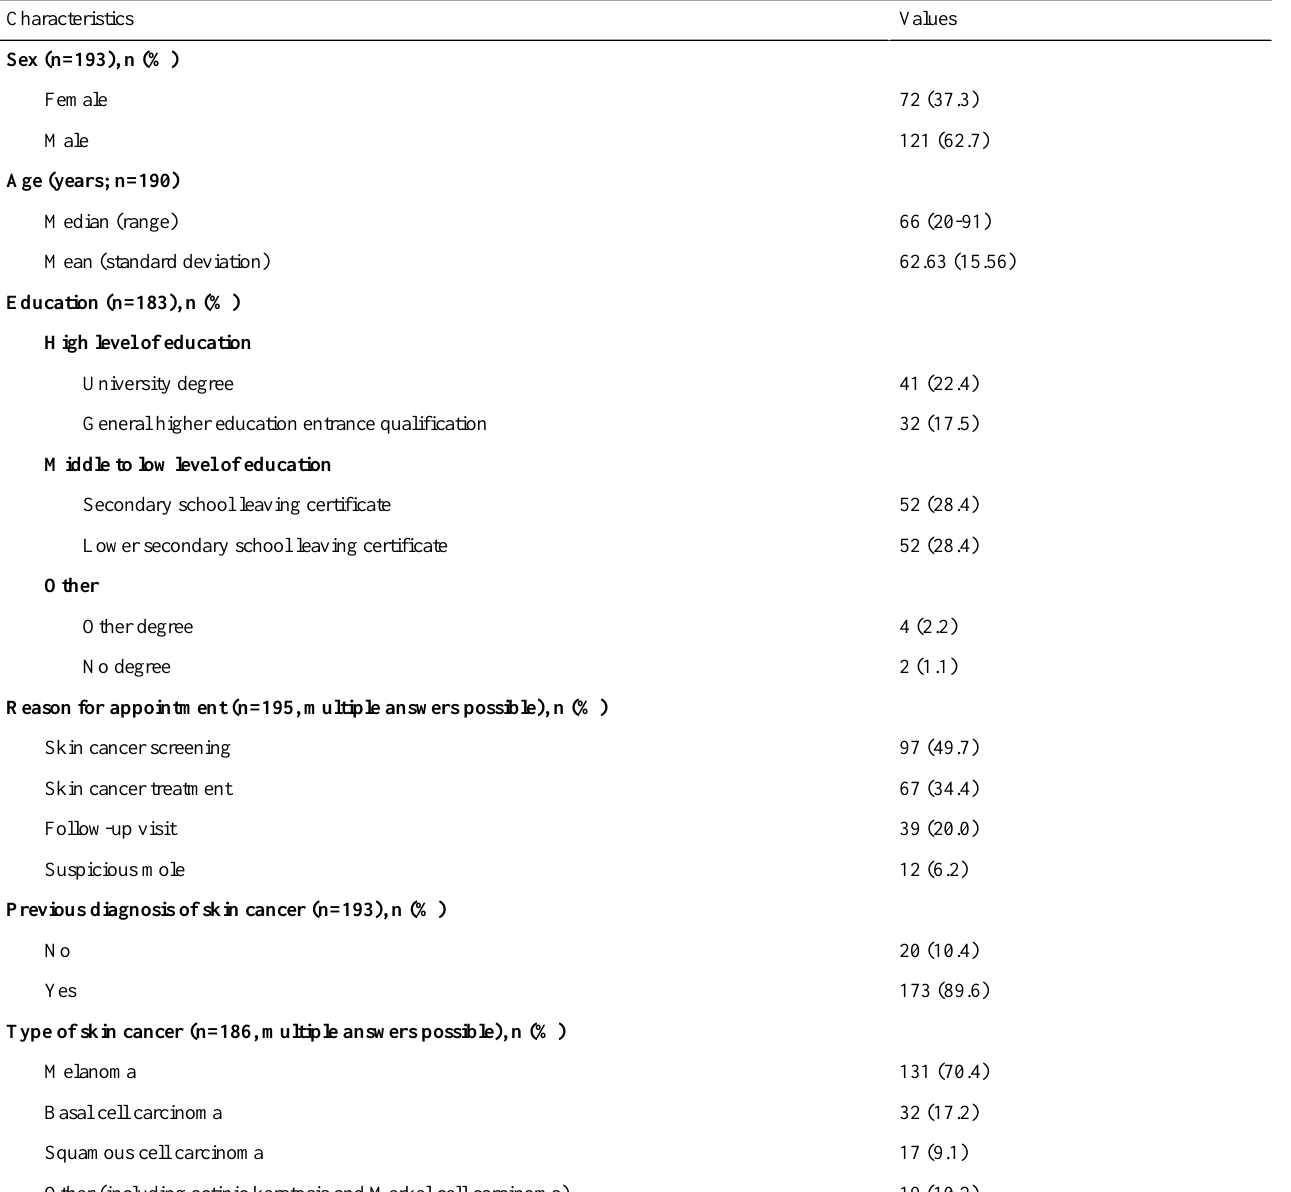
Table 1. Baseline characteristics of the study population.